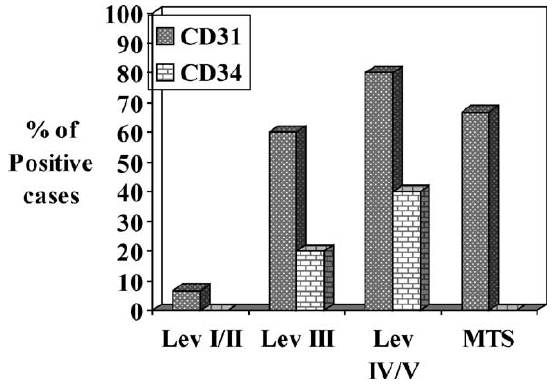
Fig. 1. CD31 and CD34 immunoreactivity in Clark’s level I–V, and metastatic melanomas (MTS): graphic representation showing the percentages of immunolabeled